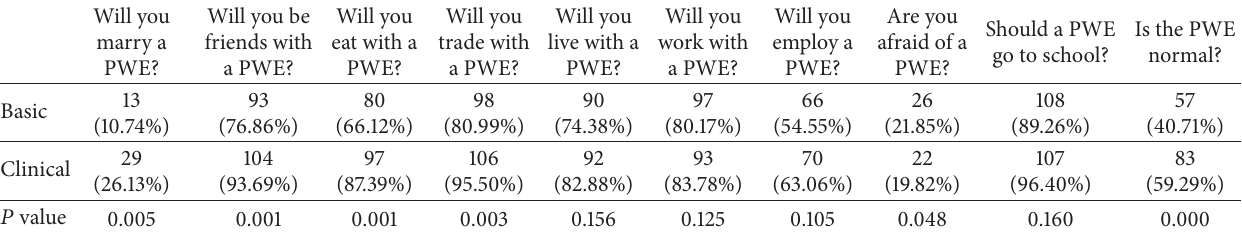
Table 3: Relationship with a